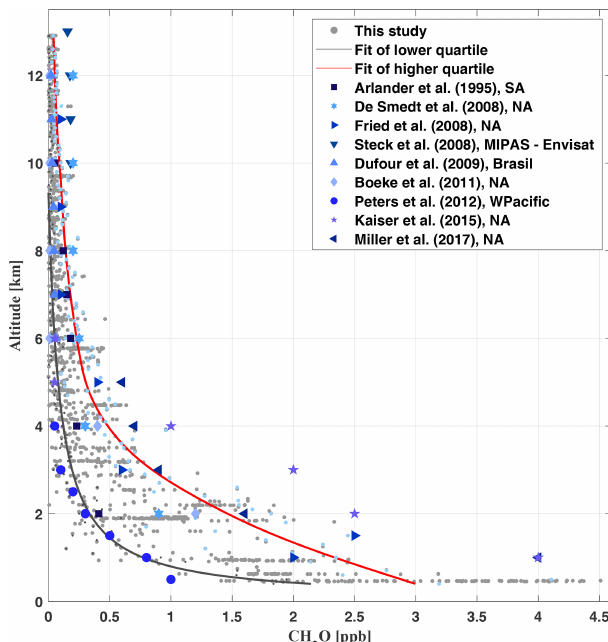
Figure 10. Comparison of different CH 2 O measurements available from the literature (Arlander et al., 1995; De Smedt et al., 2008; Fried et al., 2008; Dufour et al., 2009; Steck et al., 2008; Boeke et al., 2011; Peters et al., 2012; Kaiser et al., 2015; Chan Miller et al., 2017) with those of the present study (grey). The geograph- ical regions of the measurements are Brazil, South America (SA), North America (NA), west Pacific (WPacific), and MIPAS-Envisat measurements covering orbit 8164, 14 ◦ S, 46 ◦